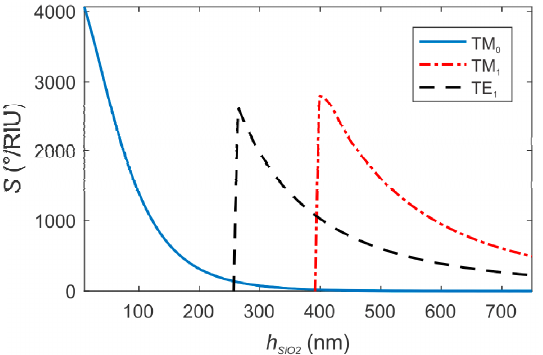
Figure 7. Bulk sensitivity S of the Au/SiO 2 sensing platforms versus h SiO2 for variation of the external refractive index from 1.33 to 1.36 RIU. Both plasmonic and DLWG regimes in TM and TE polarizations are considered.